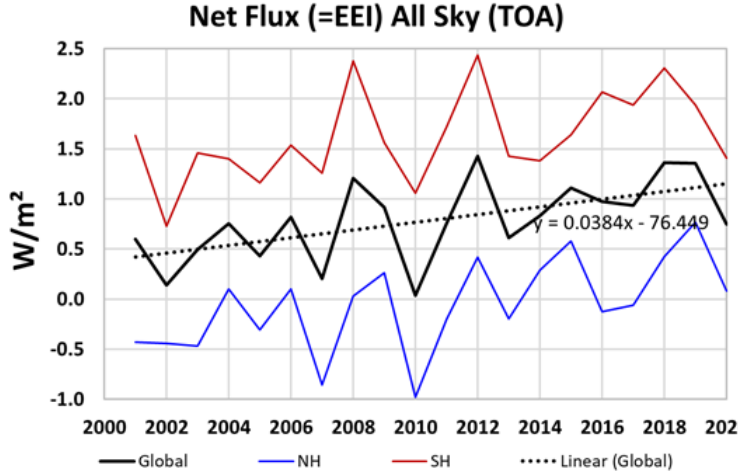
Figure 4. TOA net flux for global, NH, and SH. The Southern hemisphere obtains a higher flux (+ 1.7 W/m 2 ) than the North which is due to the aphelion/perihelion of the Earth’s rotation around the sun, resulting in a stronger radiative flux during the SH summer, not compensated by the weaker SH winter. Nevertheless, the NH has warmed up more strongly during the given period of time.